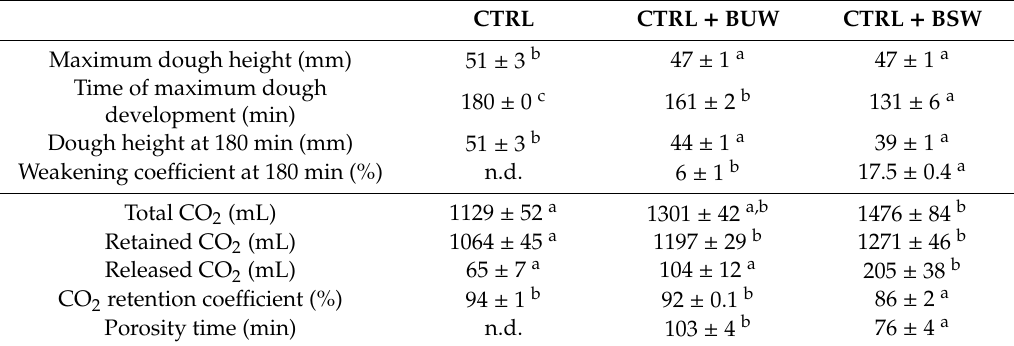
Table 4. Leavening properties of refined wheat flour alone, with bran from un-sprouted wheat, or bran from sprouted wheat. CTRL CTRL + BUW CTRL + BSW